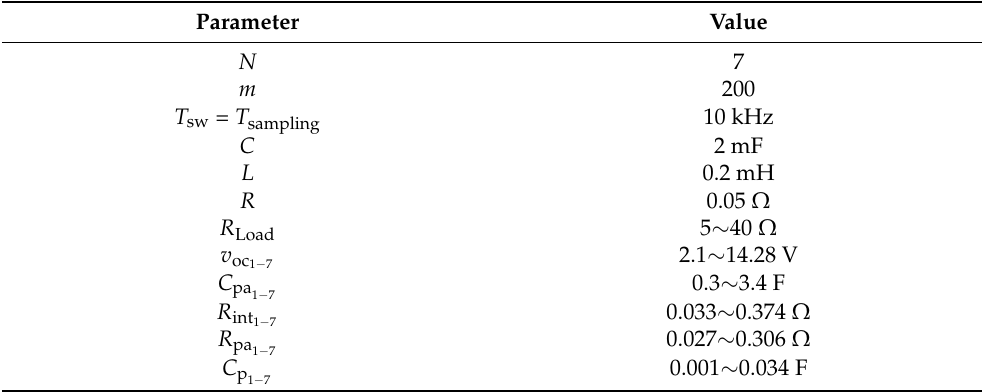
Figure 11. Scenario one: measured, denoised, and estimated output voltage of the first module ( v b Table 1. Some important parameters in the simulation and